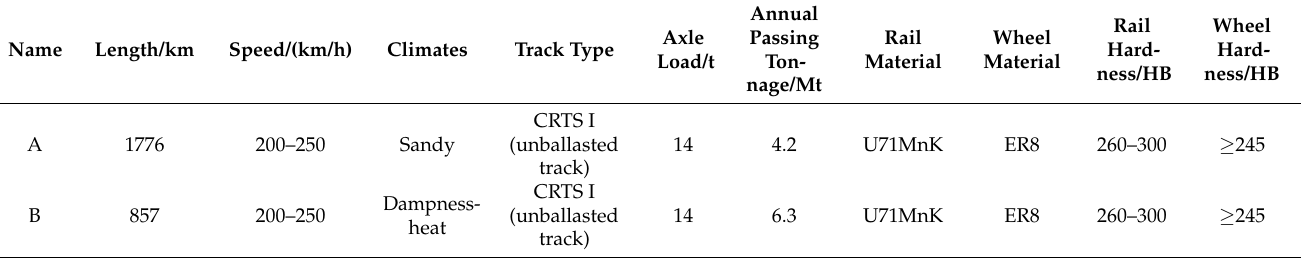
Table 1. Information about wheel-rail